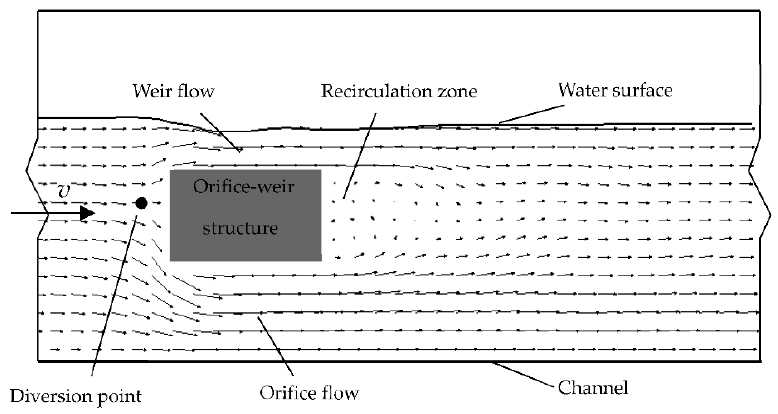
Figure 4. The schematic diagram of the flow.